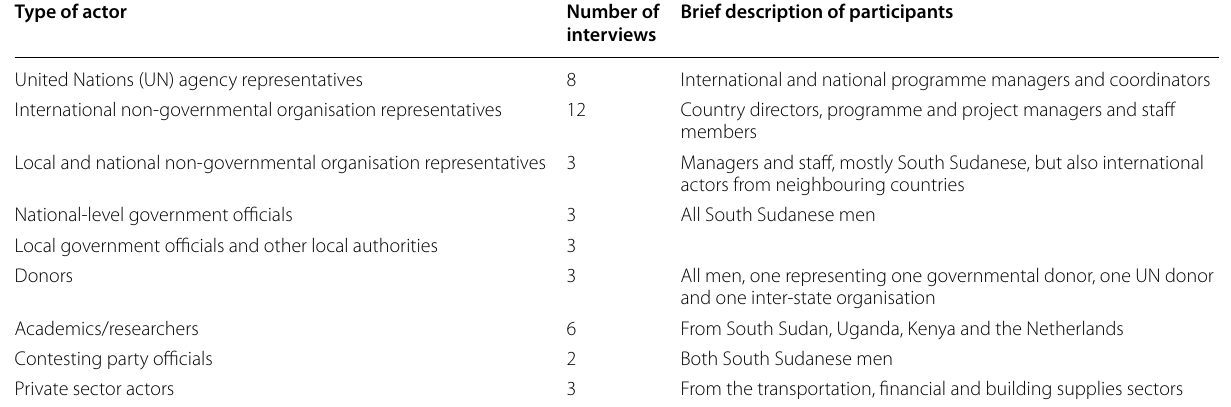
Table 1 Interview and focus group participants Type of